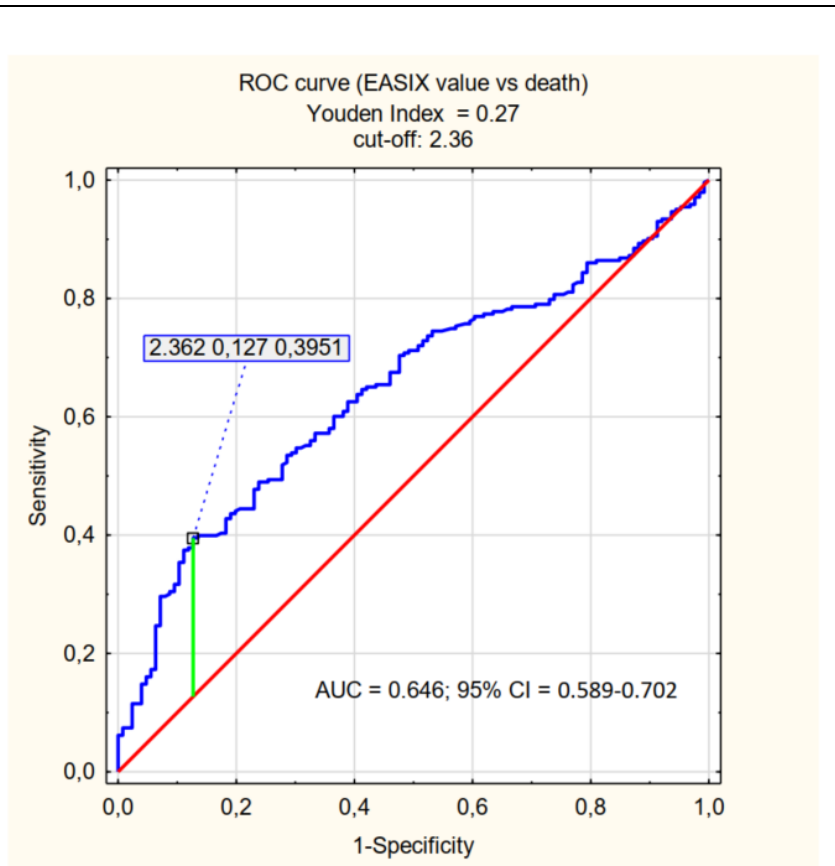
Figure 1. ROC curve (effect of EASIX value on death) = EASIX cut-off.